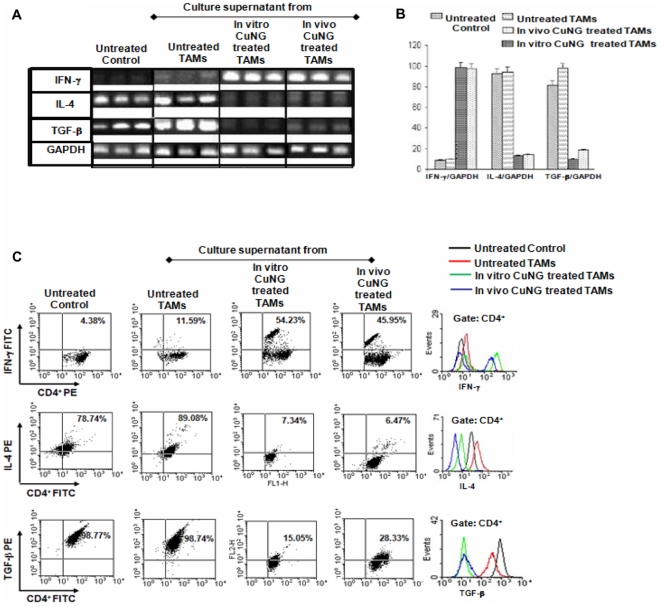
Culture supernatant of TAMs, treated with CuNG, caused altered cytokines production by TALs.A) RT-PCR. B) Densitometric analysis. C) Flow cytometry. CD4+ T cells were purified from TALs obtained from untreated EAC/Dox bearing mice and cultured for 96 h with cell free supernatant of TAMs obtained from untreated EAC/Dox bearing mice that were either kept untreated for 48 h or treated with CuNG (48 h treatement) in vitro or with cell free supernatant of TAMs (cultured for 48 h in absence of CuNG) obtained from in vivo CuNG (15 days after treatment, i.e., when tumors start regressing prominently) treated EAC/Dox bearing mice. Cytokine profile was analyzed by semi-quantitative RT-PCR. Purified CD4+ population from TALs (derived from untreated EAC/Dox bearing mice) cultured without any treatment were used as untreated control. After completion of 96 h of incubation equivalent amount of mRNA (2 µg) from TALs of each experimental group was used for RT-PCR analysis and representative data from three independent experiment is presented (A). In all cases GAPDH was used as housekeeping gene control. Densitometry analysis of mRNA expression of each gene transcript was expressed as a ratio of cytokine mRNA to GAPDH mRNA (B). Intracellular cytokines specific for Th1 (IFN-γ) or Th2 (IL-4) or suppressive (TGF-β) production profile in the above mentioned experimental groups were also analyzed by flow cytometry and representative data of three independent experiments is presented here (C).